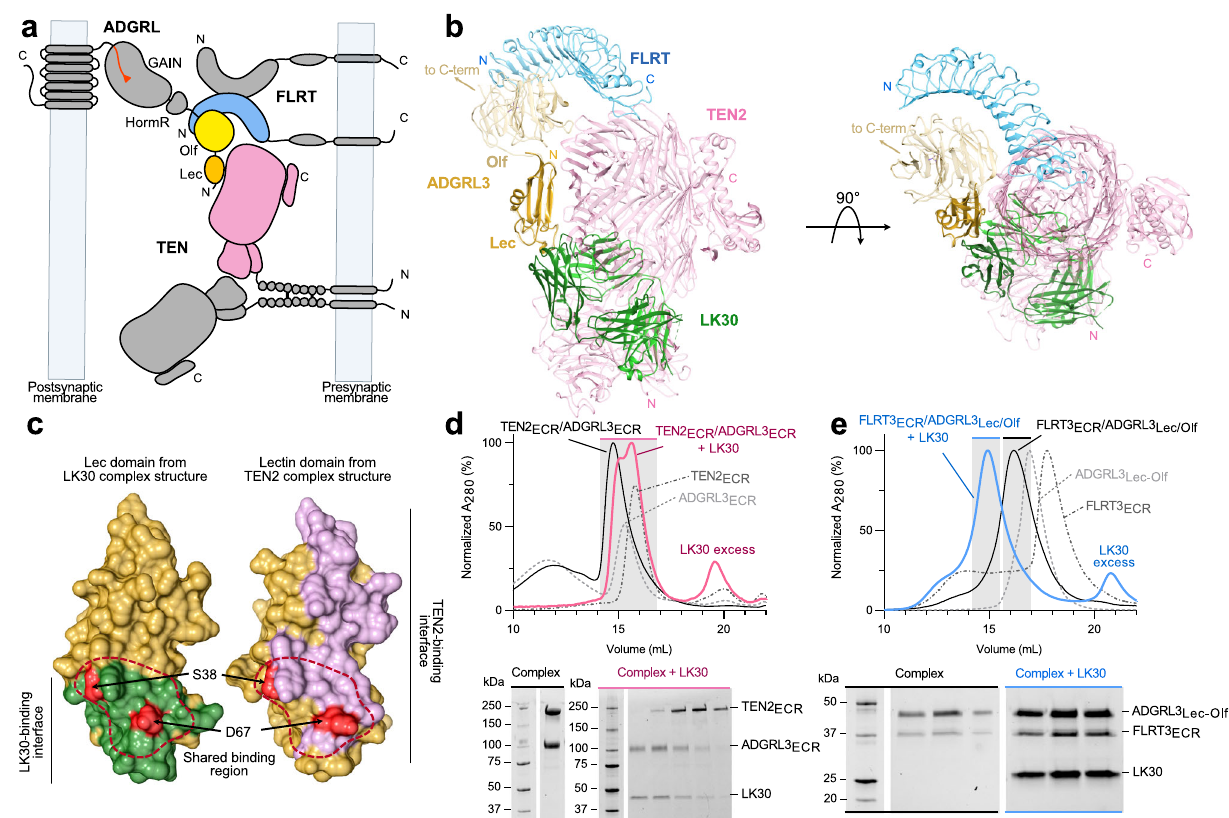
Fig. 4 | LK30 blocks the interaction of ADGRL3 with TEN2 but not with FLRT3. a SchematicdiagramoftheinteractionnetworkbetweenTEN,ADGRL,andFLRTat the synapse. TEN and FLRT are localized on the presynaptic cell membrane, while ADGRL is localized on the postsynaptic membrane. b Superimposition of the ADGRL3 Lec /LK30 complex with the ADGRL1/TEN2 complex structure (PDB: 6SKA) and trimeric complex of ADGRL3 and FLRT2 (PDB: 5FTU). The ADGRL domains of all structures are superimposed. ADGRL3 Lec and LK30 are colored yellow and green, respectively, TEN2 molecule is colored pink, FLRT is colored blue. The Lec and Olf domains bound to TEN2 and FLRT2 are colored tan. c Detailed analysis of ADGRL3 Lec domain regions interacting with either LK30 (left, in green) or TEN2 (right,inpink).BindingareasharedbybothligandsonLecdomainisindicatedbya red dashed-line. Position of residues S38 and D67 shown as red patches. d SEC pro fi lesshowing the disruption ofthe ADGRL3/TEN2 complex (black curve)by the